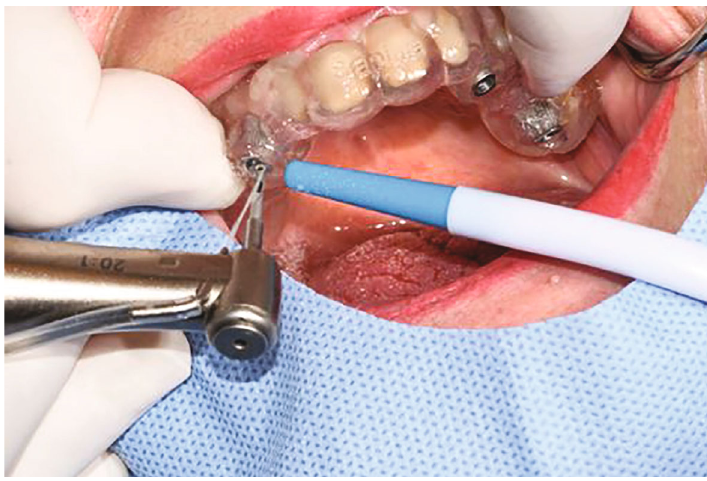
Figure 5: Osteotomy using a pilot drill and a surgical guide.